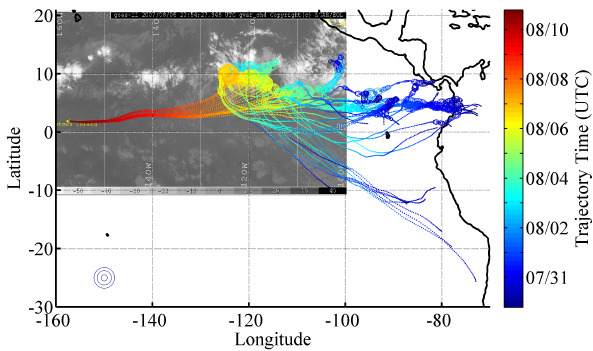
Fig. 7: Back trajectories from Case Study I overlaid on a Fig. 7. Back trajectories from case study I overlaid on a GOES IR image from 6 August, 23:59UTC. Trajectories are color-coded GOES IR image from 6 August, 23:59 UTC. Trajectories are with time, while marker size reflects modeled precipitation along color-coded with time, while marker size reflects modeled the path. The blue circles in the lower left corner exemplify precip- precipitation along the path. The blue circles in the lower itation intensities of left corner examplify precipitation intensities of 1/5/10 mm.